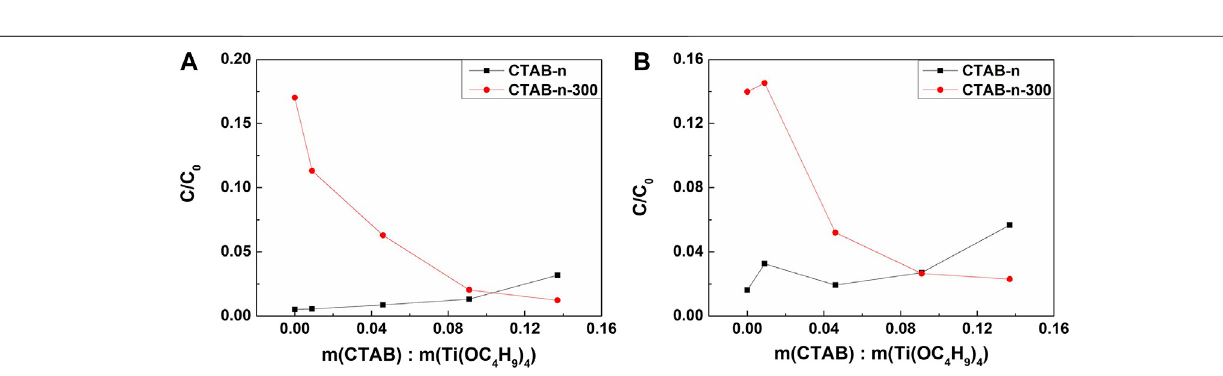
FIGURE 8 | (A) The GV concentration percentage after exposure to irradiation for 120 min; (B) the MB concentration percentage after exposure to irradiation for 120